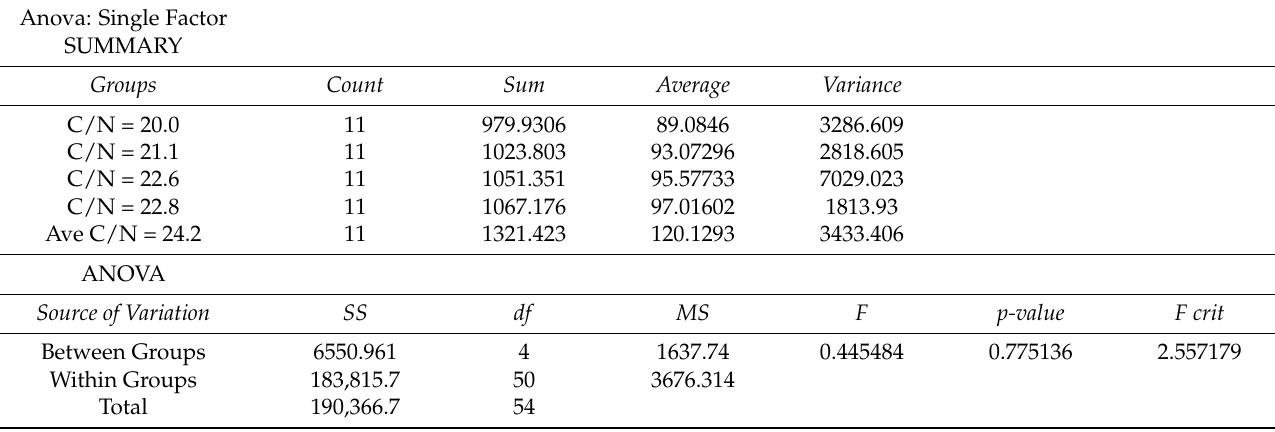
Table A6. One-way (ANOVA) test for methane yield every three days from the first five reactors. Anova: Single Factor